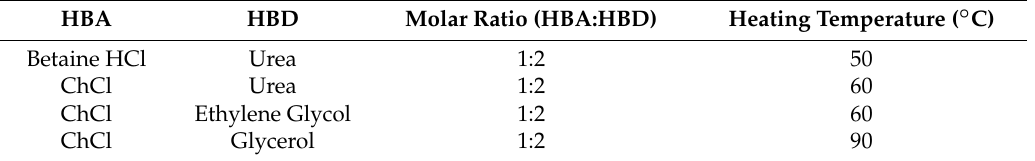
Table 1. List of the synthesis of deep eutectic solvents (DESs) used in this study. HBA HBD Molar Ratio (HBA:HBD) Heating Temperature ( ◦ C) Betaine HCl Urea 1:2 50 ChCl Urea 1:2 60 ChCl Ethylene Glycol 1:2 60 ChCl Glycerol 1:2